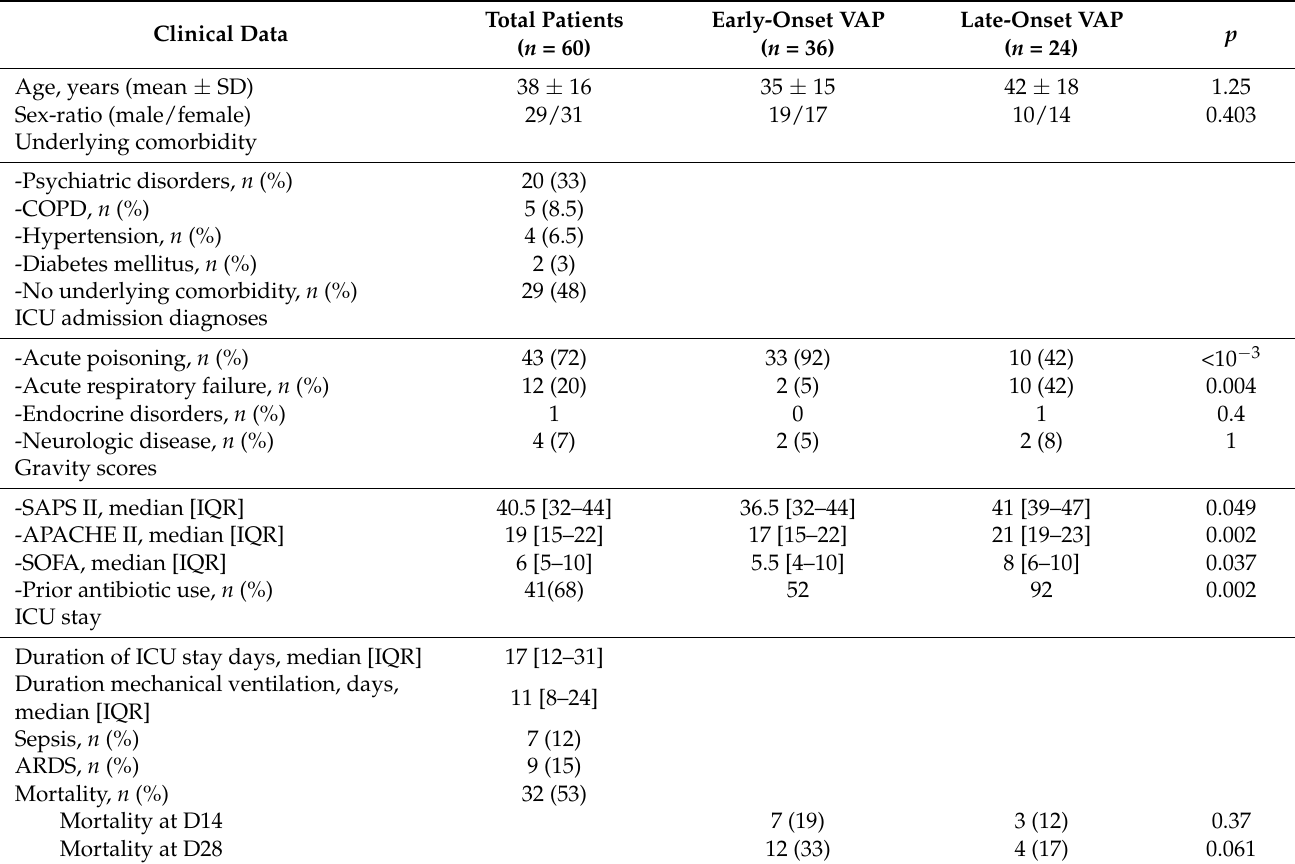
Table 1. Baseline demographic and clinical characteristics of early-onset versus late-onset ventilator-associated pneumonia. Clinical